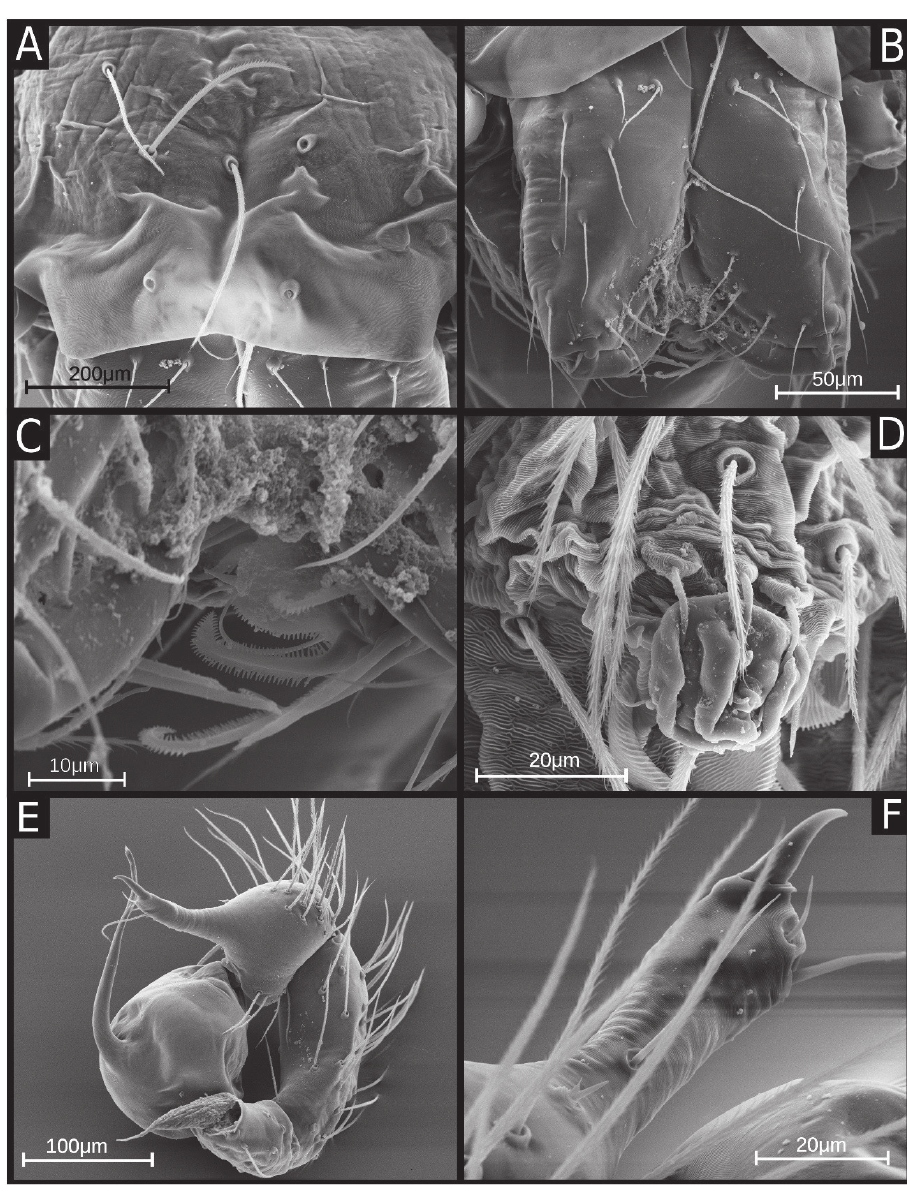
Figure 2. SEM images of Ochyrocera dorinha sp. nov., male (IBSP 198876) A carapace, anterior view B chelicerae, frontal view C endites, crosier-like macrosetae, dorsal view D epiandrous area, abdomen, ventral view E male palp, prolateral view F cymbium, distal